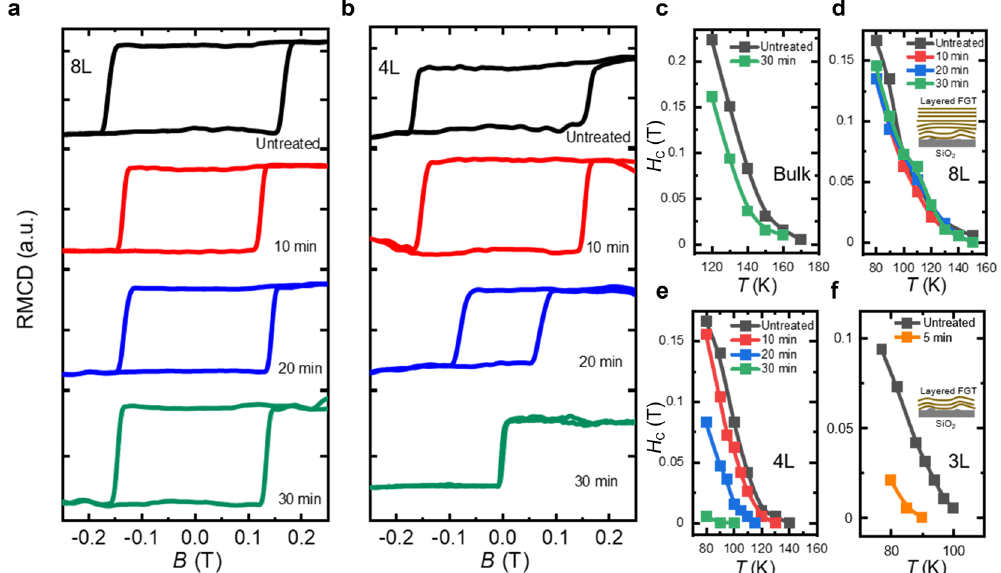
Fig. 4 Magnetic hysteresis loops and temperature-dependent coercivity fi elds of Fe 3 GeTe 2 samples of different thicknesses. a , b Magnetic hysteresis loops at 80 K for the 8 L and 4 L Fe 3 GeTe 2 samples with progressive treatments. c – f Temperature-dependent coercivity fi elds of the bulk, 8 L, 4 L, and 3 L Fe 3 GeTe 2 samples with progressive treatments. The insets of ( d ), ( f ) show the top surfaces of thick and thin Fe 3 GeTe 2 samples on SiO 2 are relatively fl at and rough,